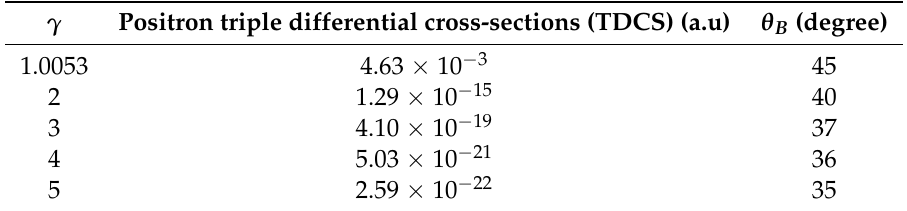
Table 1. The maximum values of the triple differential cross-sections (TDCS) and the peak position for the positron-impact ionization of Hydrogen for five incident positron